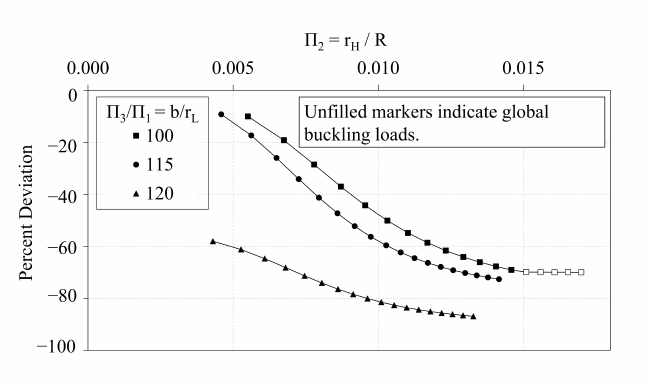
Figure 12. OLC Π 0 vs. Π 2 Percent deviation of analytical predictions from FE predictions [26].